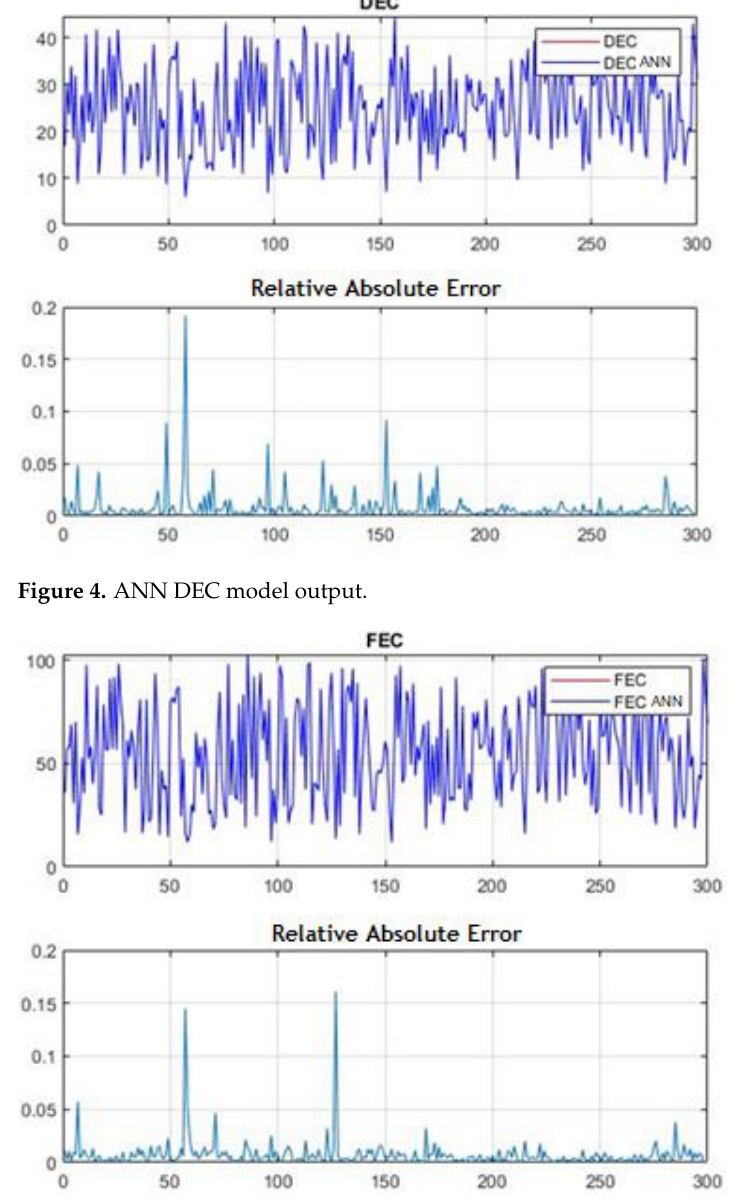
Table 4. The heat map of DEC and FEC.